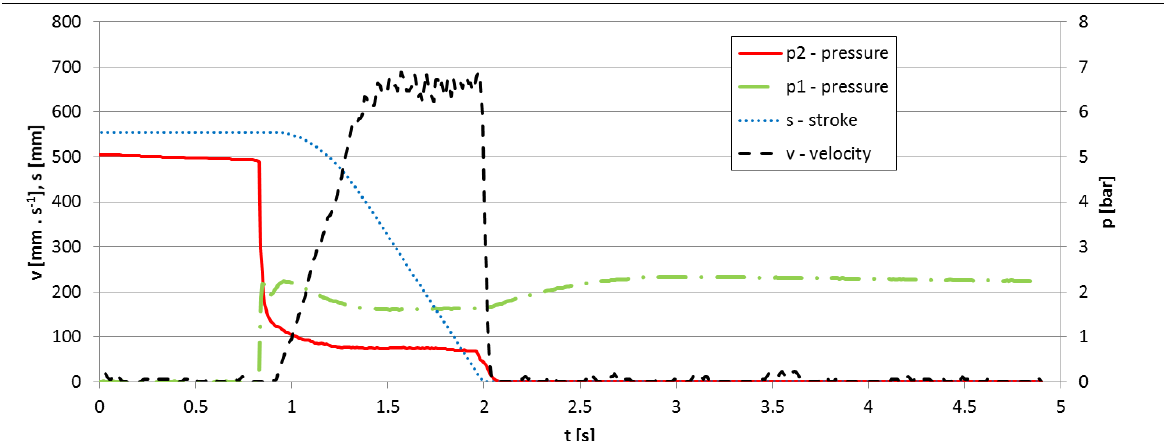
Fig. 11. Measuring results of system without cushioning